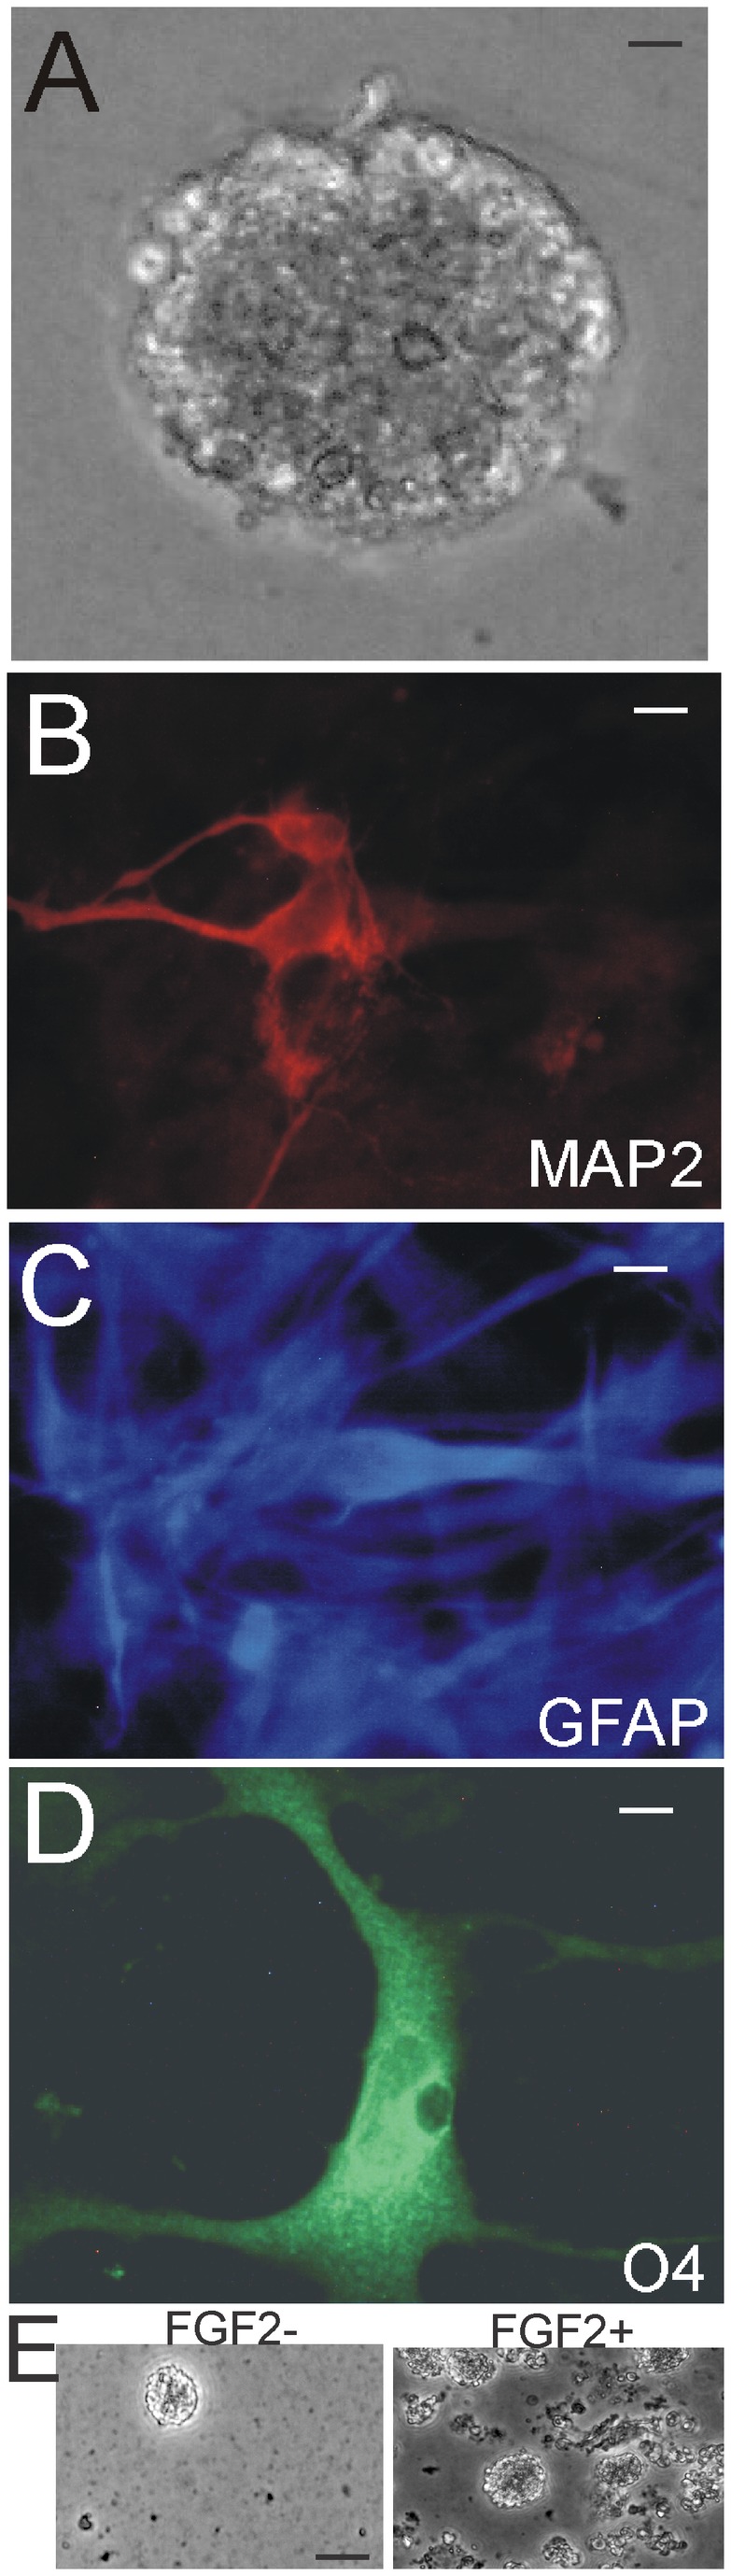
Newborn piglet OB-SVZ cells form multipotent neurospheres.
A. Floating neurosphere formed by notch-1-immunopanned NSCs isolated from the OB. Scale = 12 µm. B-D. Attached neurospheres dispersed as monolayers are multipotent by differentiating into cells that are neurons identified by MAP2, astrocytes identified by GFAP, and oligodendrocytes identified by O4. E. Neurosphere density increased when medium was supplemented with FGF2. Scale bars = 12.5 (B), 20 (C), 20 (D), 50 (E) µm.